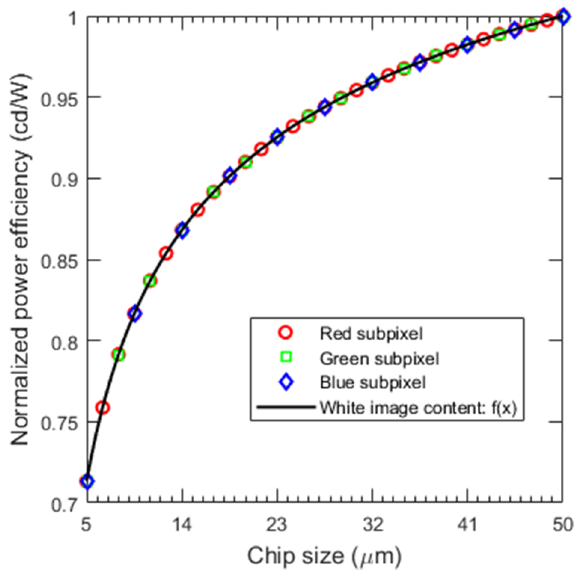
Figure 12. LED chip size-dependent power efficiency of color-conversion micro-LED display.